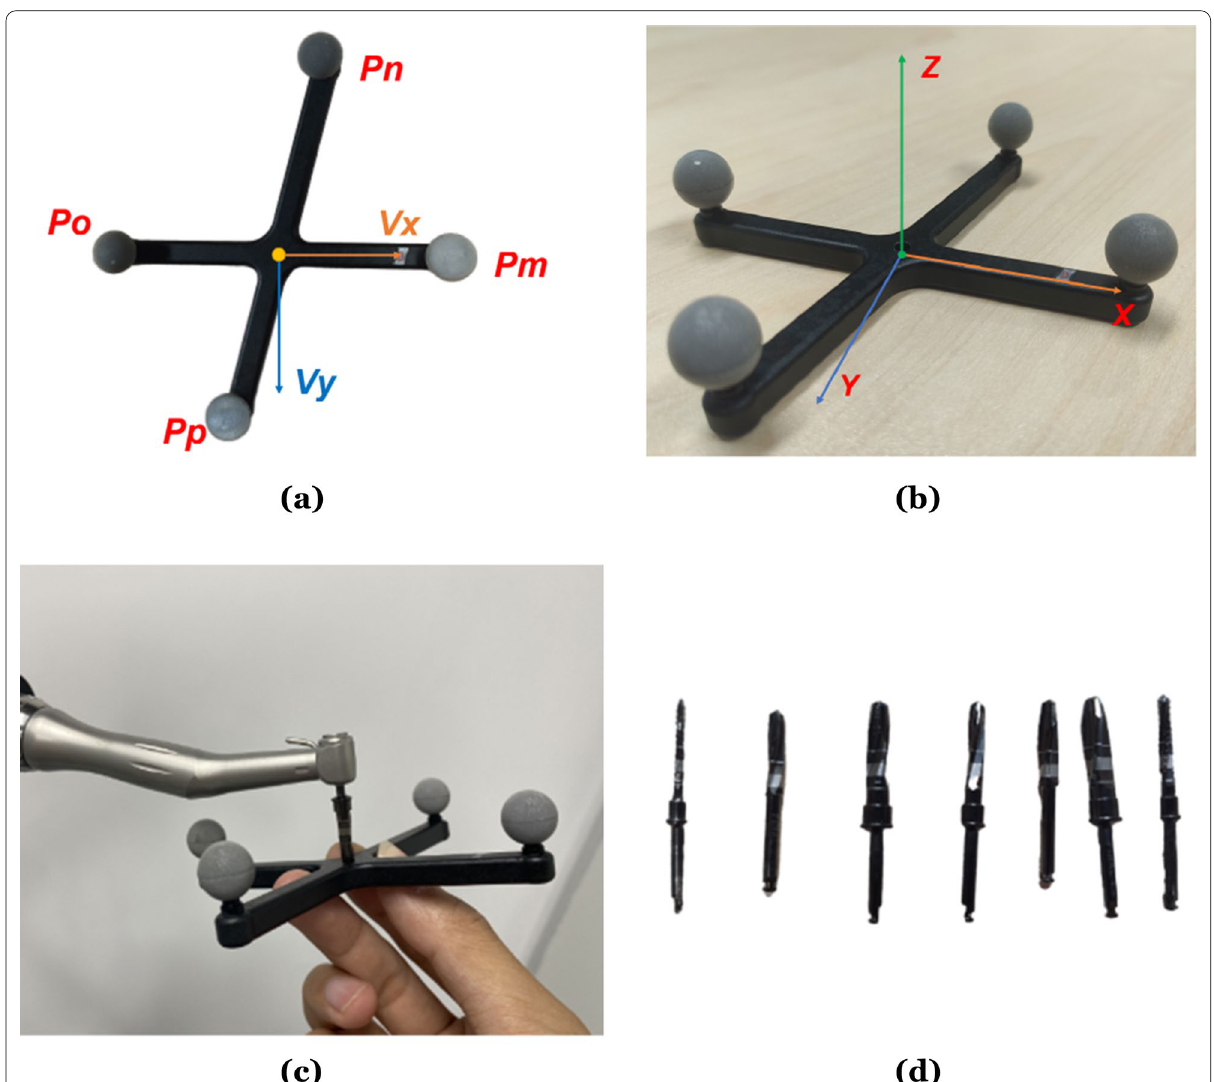
Figure 6 The x-shaped tool: a Vertical view, b Establish the coordinate system of C p , c Use the x-shaped tool to determine the position of the needle tip and keep it vertical to determine the direction of the needle body, d Some drill needles of different